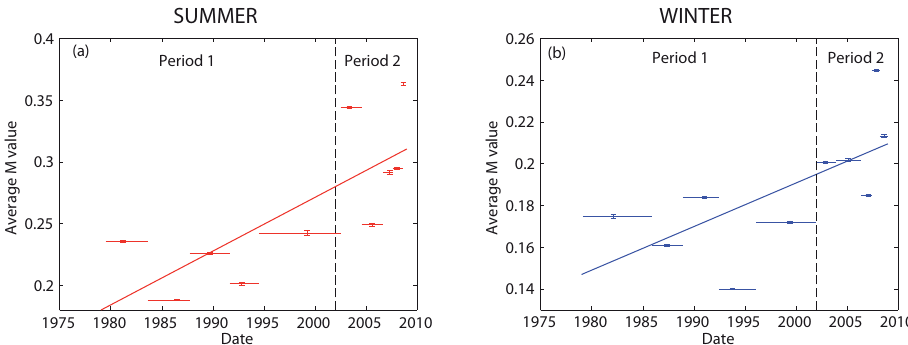
Fig. 10. Time series M(t) from January 1979 to December 2008 computed using (a) the summer dataset and (b) the winter dataset. For each season, the dataset is equally split into 10 bins over which the average is computed. One bin corresponds to approximately 3.1 × 10 4 M values in summer and 8.0 × 10 4 M values in winter. The horizontal lines associated with each data point indicate the time period associated with each bin. Vertical lines are error bars computed from a bootstrap method. Bold lines are linear fits: the trends are 1.19( ± 0.34) × 10 − 5 yr − 1 (i.e. 16.5% increase per decade) for summer and 5.7( ± 1.9) × 10 − 6 yr − 1 (i.e. 11% increase per decade) for